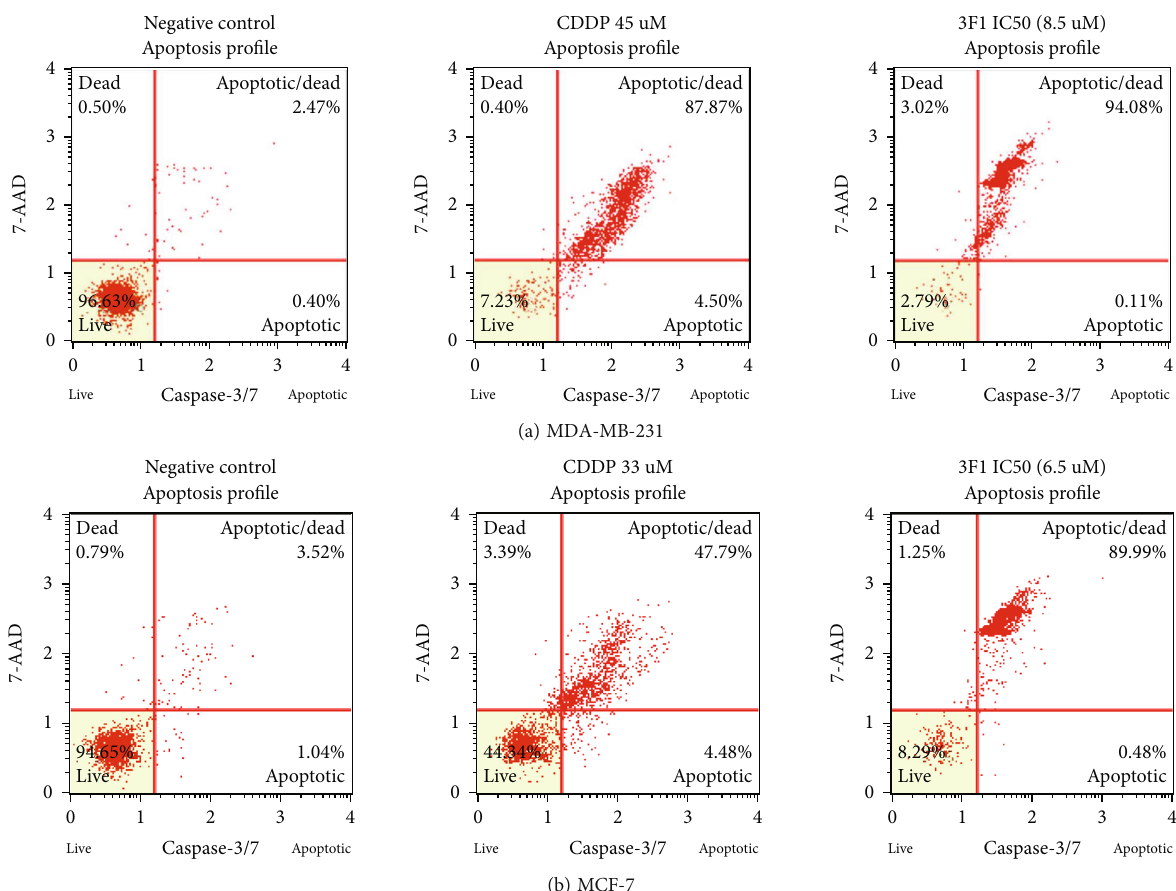
Figure 6: Caspase-3/-7-dependent apoptosis in cells treated with compound 3F1 were detected using a MUSE fl ow cytometer. MDA-MB- 231 (a) and MCF-7 (b) cells were treated for 24 h with the respective IC dose of the novel gold-based compound 3F1 or with the respective 50 dose of cisplatin (CDDP) for positive control samples or with 0.1% DMSO for the negative controls. Apoptotic cells with activated IC 50 caspase-3/-7 are plotted in the upper and lower right quadrants. Viable cells are plotted in the left lower quadrant, whereas necrotic cells are shown in the left upper quadrant of the representative scattered